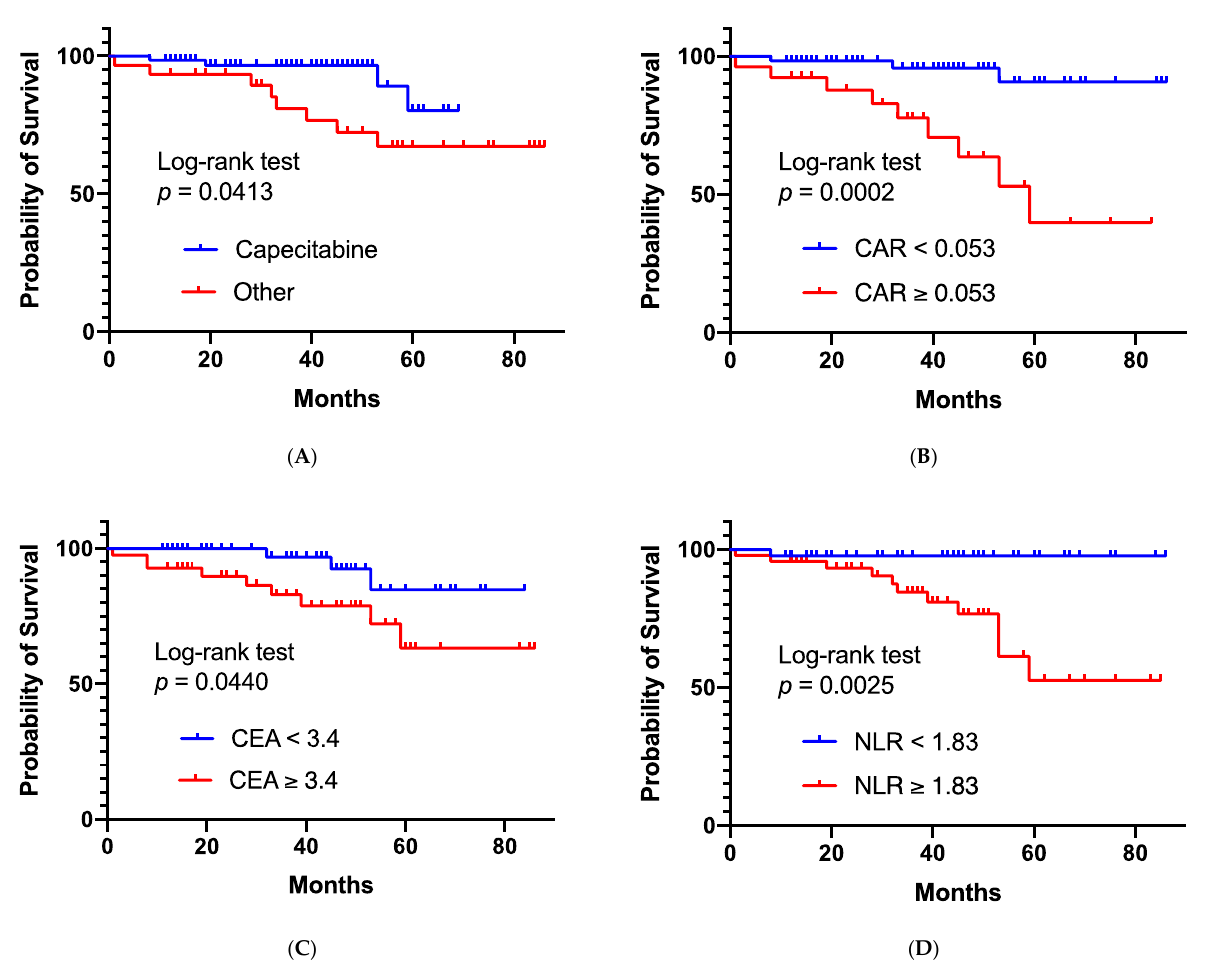
Figure 2. Overall survivals per each risk factor. Cumulative rates of overall survival for each risk factor, which were identified in univariate analyses using Cox regression analysis. Poor overall survival was significantly associated with no concurrent administration of capecitabine ( A ), high C-reactive-protein-to-albumin ratio (CAR) ( B ), high carcinoembryonic antigen (CEA) ( C ), and high neutrophil-to-lymphocyte ratio (NLR) ( D ).